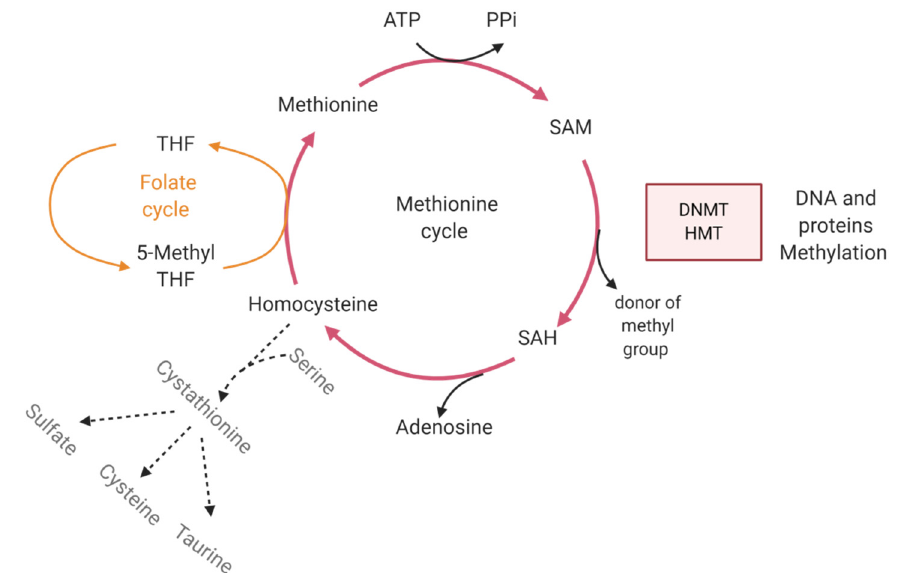
Figure 3. The methionine cycle and alternative homocysteine degradation regulate DNMT and HMT activity. HMT and DMMT catalyze histone and DNA methylation, respectively. The donor of the methyl group is the metabolite S-adenosylmethionine (SAM) which is then converted into S -adenosylhomocysteine (SAH). SAH is regenerated into SAM during the methionine cycle (red lines) where the loss of adenosine induces its transformation into homocysteine. The methyl group of 5-Methyltetrahydrofolate (5-MethylTHF) from the folate cycle (orange lines) is then transferred to homocysteine to form methionine. Depending of the metabolic needs, homocysteine can be catabolized into sulfate, taurine or cysteine. This alternative pathway is represented by dotted lines. The regeneration of SAH into SAM is then compromised and negatively impacts HMT and DNMT activity. Created with BioRender.com.